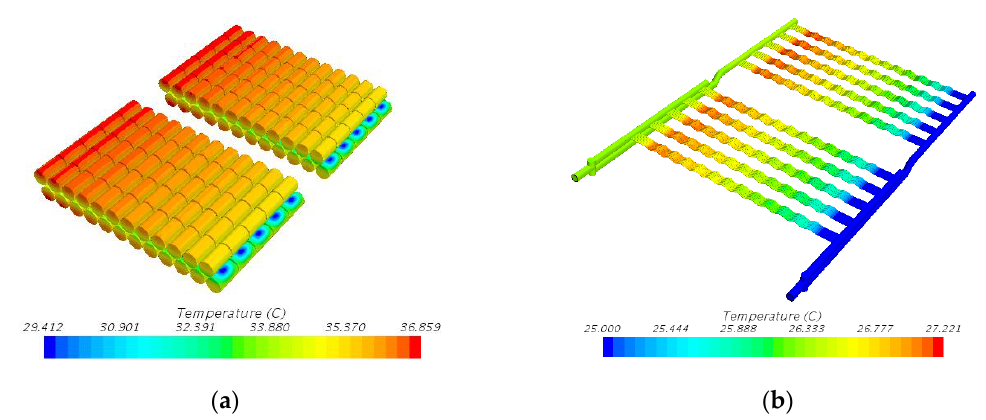
Figure 12. The temperature field at the worst working condition with an effective current at 25 A and δ = 0.973, Q = 5 L/min, and N = 6: ( a ) batteries; ( b ) coolant. Table 5. Matrix list with variable boundary conditions.